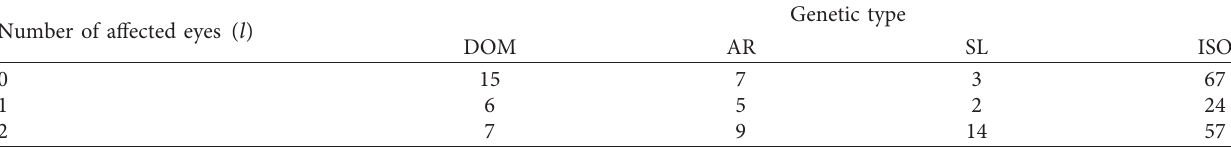
Table 11: The number of affected eyes in each genetic type.